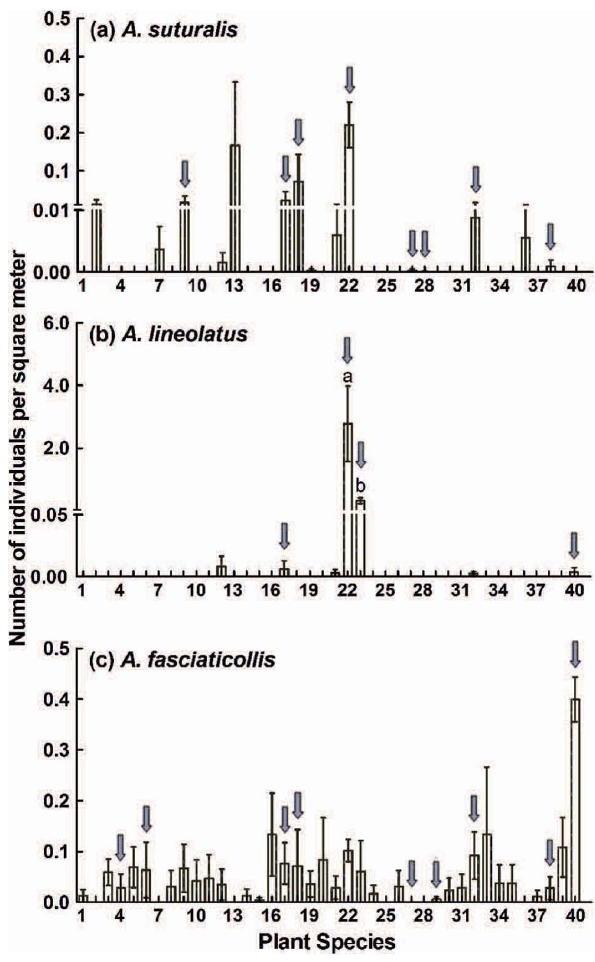
Figure 1. Comparison of the population density of each Adelphocoris species on different plant species. Data are shown as mean 6 SE. Different letters denote significant differences between plant species. The gray arrows indicate that the plant species are both overwinter and spring hosts for a specific Adelphocoris sp. Plant species: 1 Abutilon theophrasti Medic., 2 Amorpha fruticosa L., 3 Artemisia